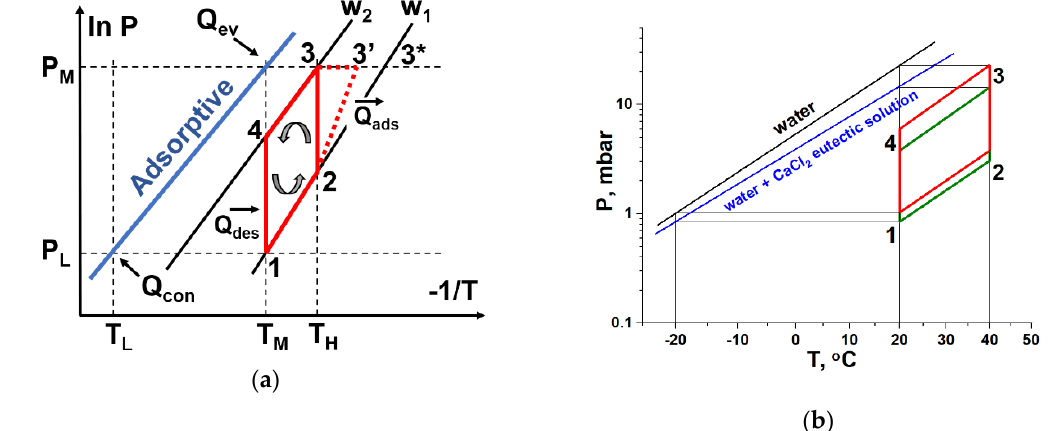
Figure 1. ( a ) P-T diagrams of a common isothermal (1–2–3–4) and non-isothermal (1–2–3’–4) 3T "Heat from Cold" (HeCol) cycles; ( b ) comparison of the HeCol cycles with pure water and a eutectic “CaCl 2 - water” solution in both evaporator and